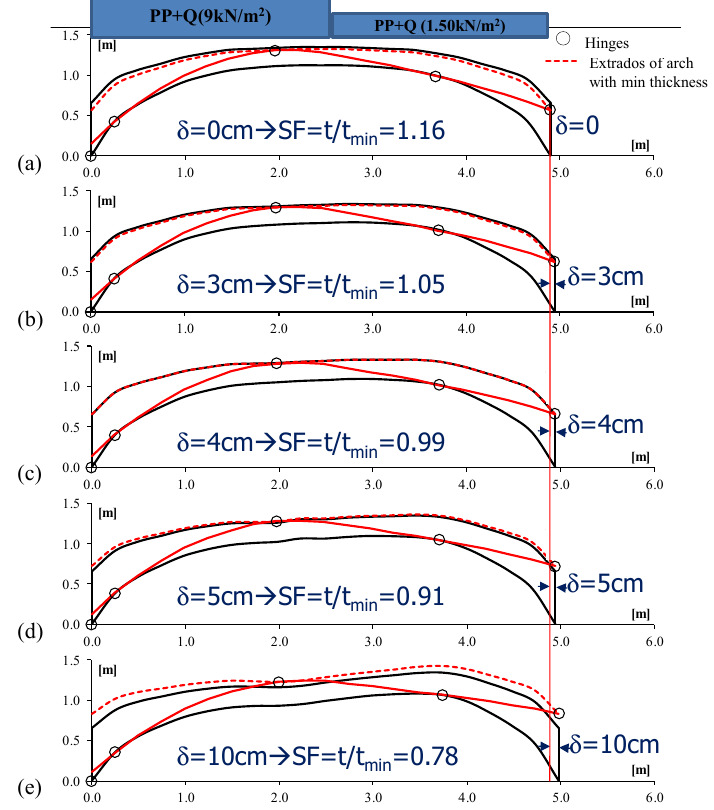
Figure 7. Evolution of geometrical safety factor SF for the arch in x-direction for different values of the horizontal settlement δ imposed at the right constraint of the arch: ( a ) δ = 0; ( b ) δ = 3 cm; ( c ) δ = 4 cm; ( d ) δ = 5 cm; and ( e ) δ = 10 cm.